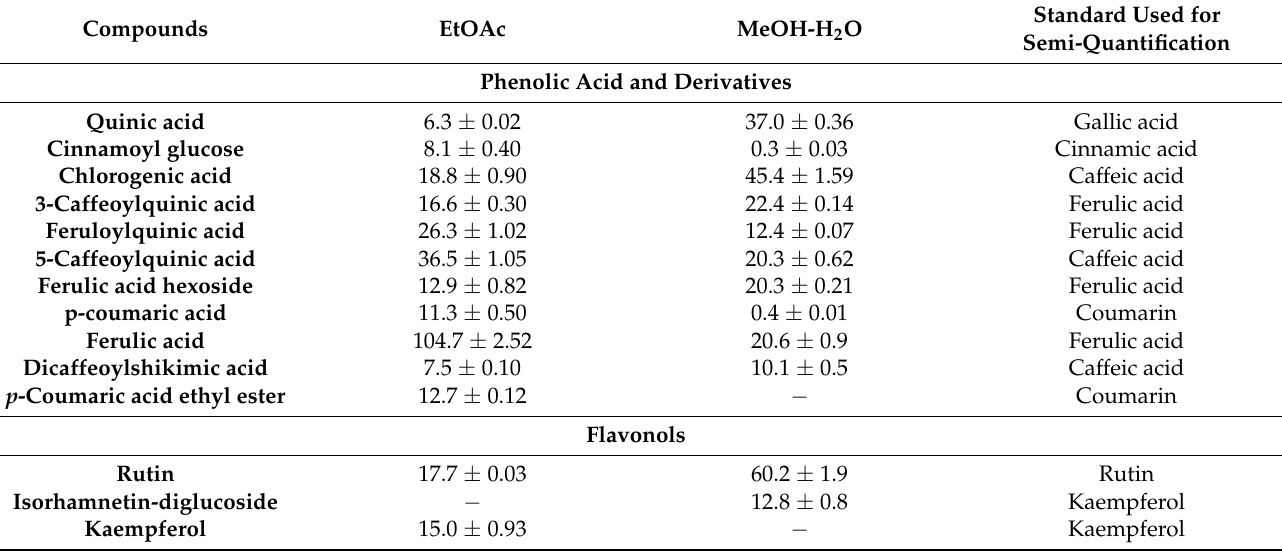
Table 7. Semi-quantification of polyphenols detected in C. humilis fruits in µ g/g ( w / w ). Compounds EtOAc MeOH-H 2 O